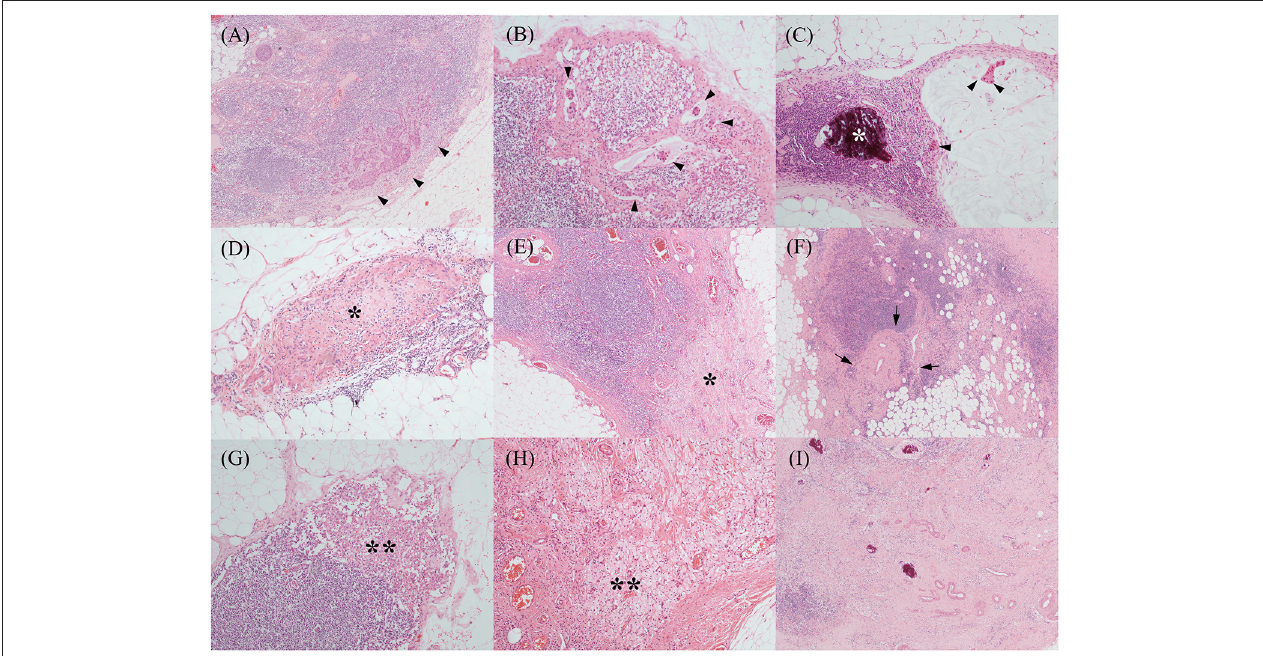
FIGURE 2 | Various treatment-related histopathological findings of axillary lymph nodes. Metastatic tumor cells were often identified at the subcapsular area [ (A) , black arrowheads], which showed occasional intranodal lymphovascular emboli [ (B) , black arrowheads]. Another metastatic mucinous carcinoma (C) showed floating tumor cell clusters in the mucin pool (black arrowheads) and microcalcification (the white asterisk). Regressed lymph nodes showed a variable degree of fibrosis [ (D,E) , black asterisks] and fibro-elastic vascular change [ (F) , black arrows]. Histiocytic infiltrations [ (G,H) , black double asterisks] were also noted. Above histopathological features, such as fibrosis, vascular change, and microcalcification, were frequently mixed (I) . [All, H&E stain; original magnification, (A,E,F,I) , x 40; (B–D,G,H) , x 100].